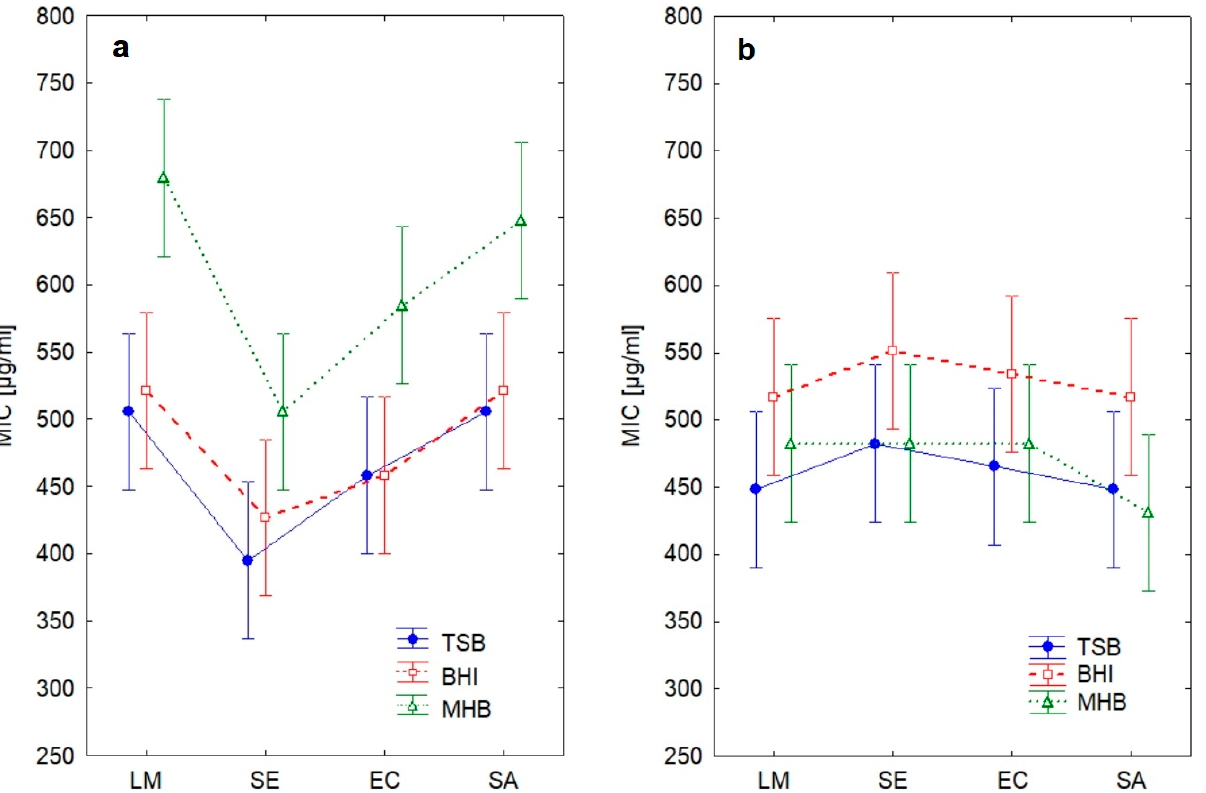
Figure 2. Differences in MIC between essential oils, growth media and pathogens (LM, Listeria mon- ocytogenes ; SE, Salmonella Enteritidis; EC, Escherichia coli O157; SA, Staphylococcus aureus ). ( a ) Ore- gano essential oil; ( b ) cinnamon essential oil.